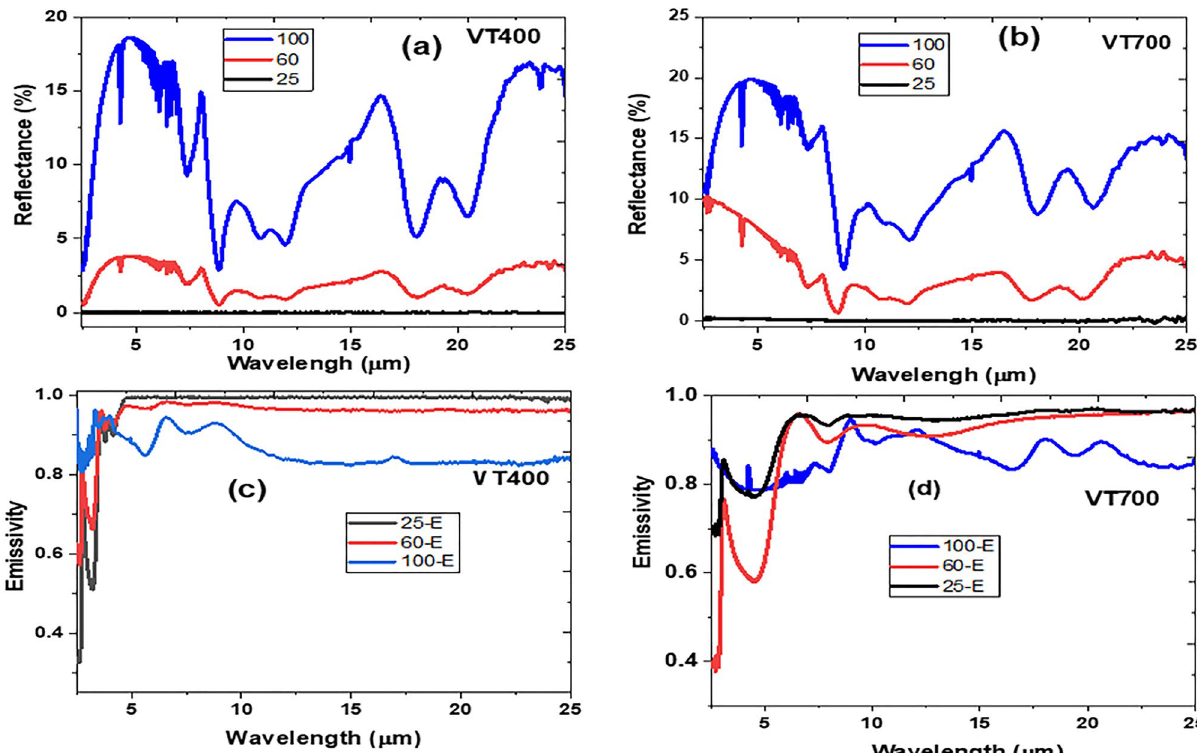
Figure 7. Variation in reflectance of the VO 2 thin films at different temperature ( a ) VT400 and ( b ) VT700; Emissivity of VO 2 thin film at different temperature ( c ) VT400 and ( d )